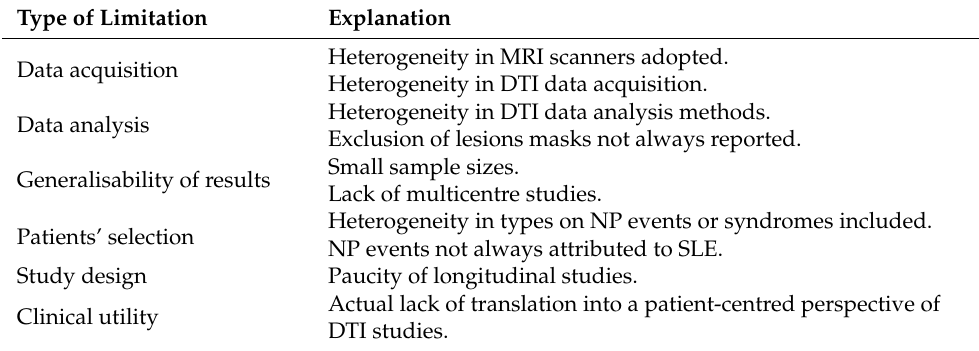
Table 4. Main research pitfalls regarding DTI studies in SLE and